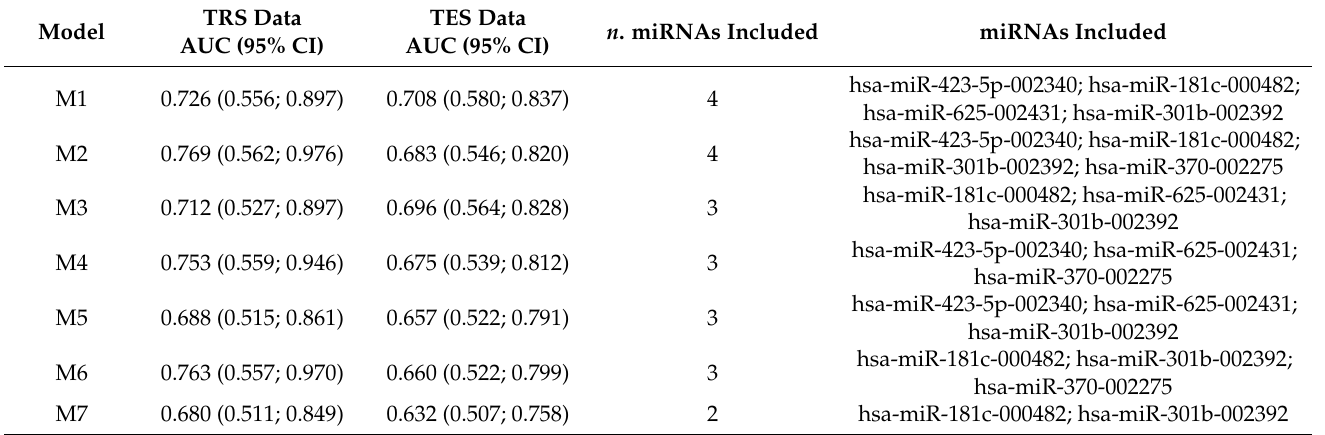
Table 3. Performance of the 7 validated signatures (M1-M7) in the breast tumor vs. benign breast lesion.